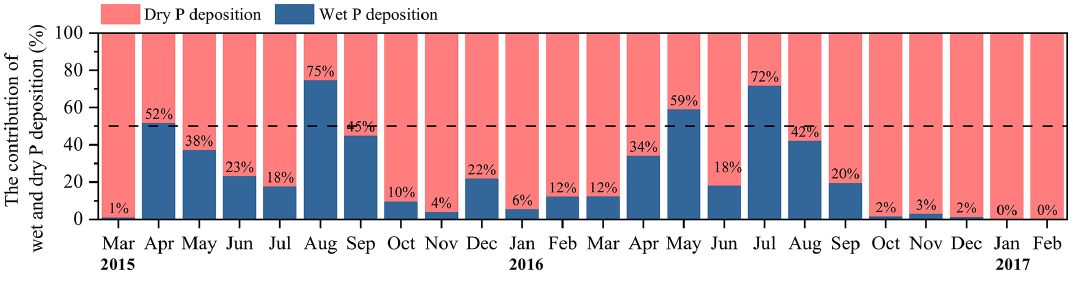
Figure 3. The contribution ratio of wet P deposition and dry P deposition to total P deposition. The middle-dashed line indicates each contributes 50%. The value represents the monthly contribution rate of wet P deposition to total P deposition.